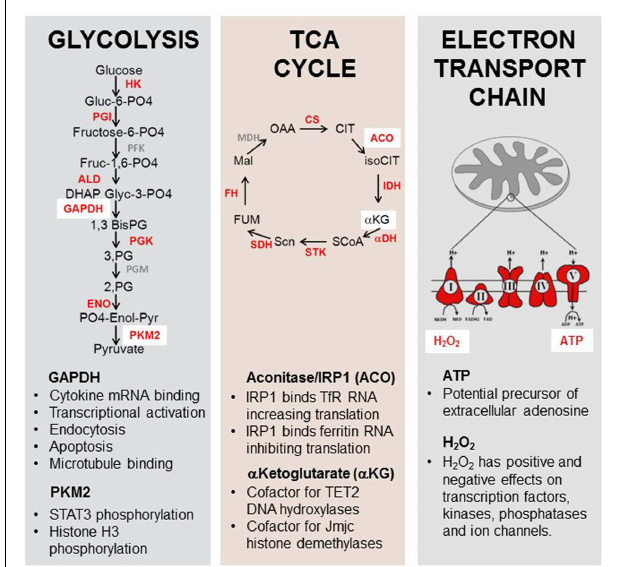
FIGURE 5 | Moonlighting functions of metabolic enzymes and metabolites . Enzymes and metabolites of the glycolysis,TCA cycle, and electron transport chain play roles in immune function. Enzymes and substrates in red have been shown to have additional non-metabolic functions in eukaryotes [reviewed in Ref. (173–176)]. GAPDH can bind to the 3 (cid:48) UTR of some cytokine genes, inhibiting their translation. Pyruvate kinase M2 has been shown to have kinase activity for the pro-inflammatory transcription factor STAT3. Aconitase functions as a rheostat for cellular iron in addition to its role in theTCA cycle. α -Ketoglutarate is an essential cofactor for the enzymesTET2 and jumonji-C histone demethylases. ATP may act as a precursor for extracellular adenosine production and H 2 O 2 has been shown to possess a signaling role in multiple cytoplasmic and nuclear